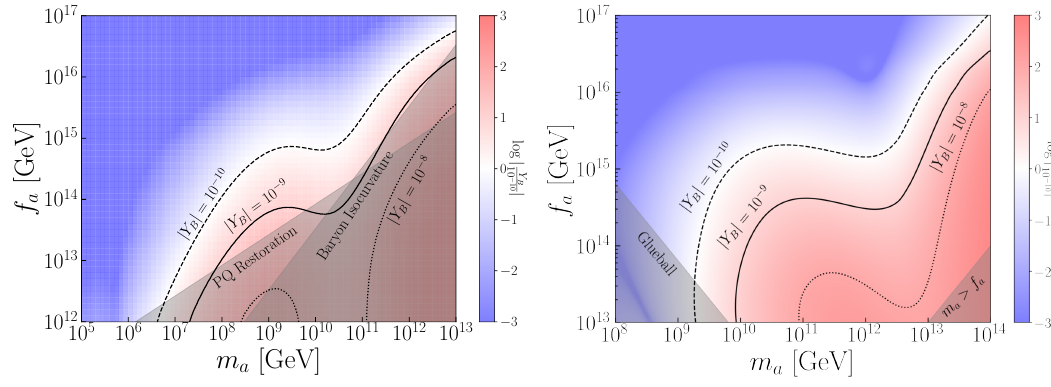
Figure 6 . As in figure 2 but with c aG = 1 , c af = 0 instead of c aG = c af = 1 for the heavy axion. This implies that the axion does not couple to fermions and that suppresses the induced baryon